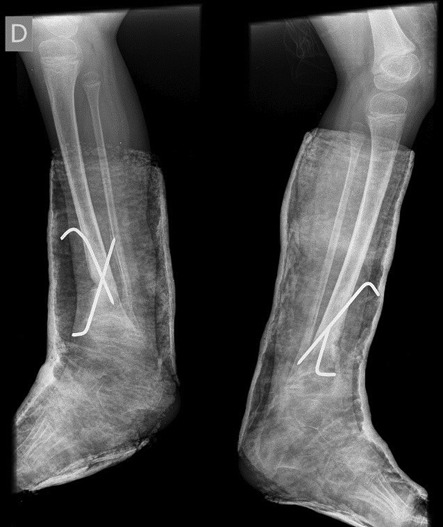
Posoperative Rx.